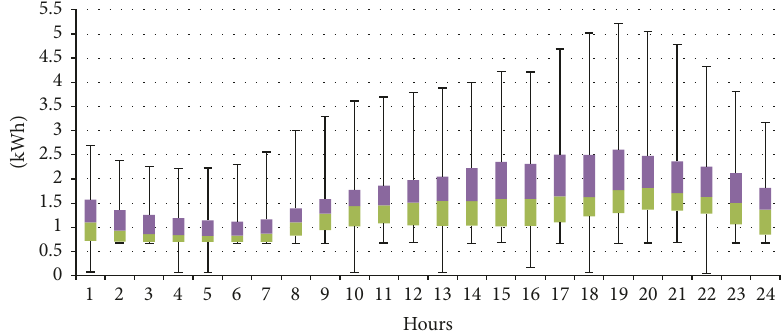
Figure 2: Customer with the least volatile consumption (in kWh) in the analyzed period (1 March 2013 to 28 February 2014).